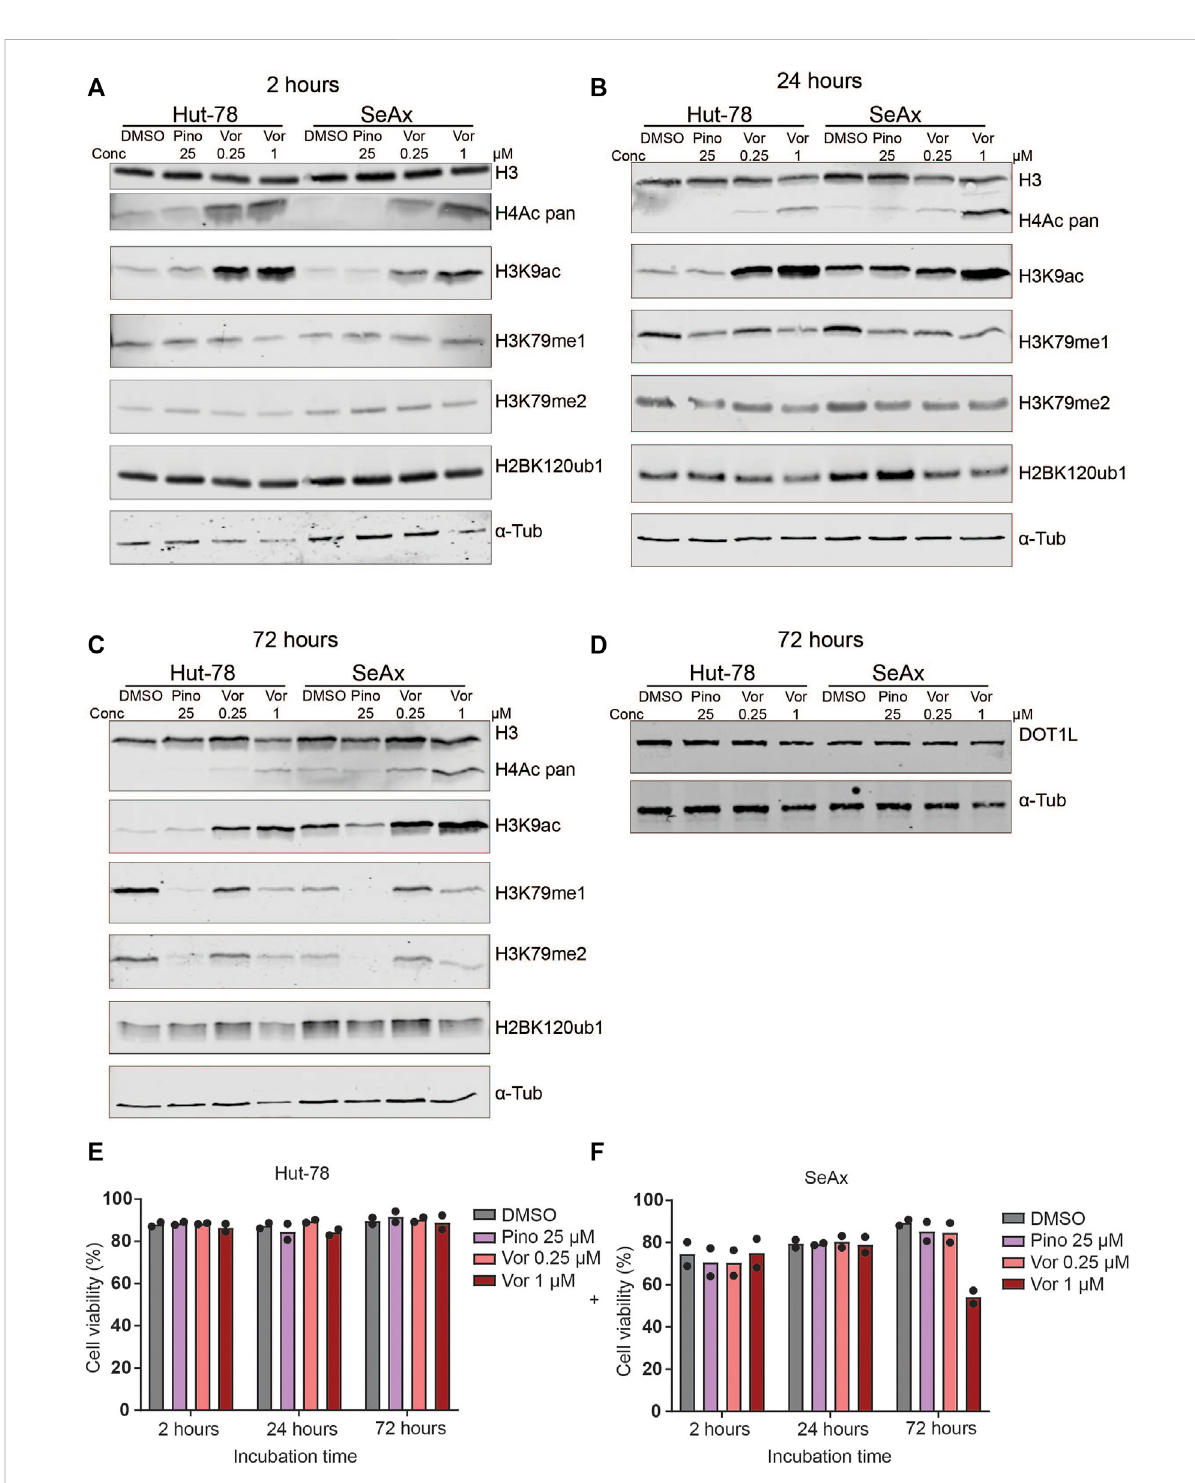
FIGURE 1 Histone modi fi cationlevelsafter treatment ofCTCL lineswithHDACinhibitorsandDOT1Linhibitors. (A – C) Westernblots showingH3K79me1/ 2, pan H4ac, H3K9ac and H2BK120ub1 levels in the indicated CTCL cell lines after treatment with 25 µM Pinometostat (Pino), and 0.25 µM or 1 µM Vorinostat (Vor) for 2 h (A) , 24 h (B) or 72 h (C) . (D) Western blot on unsonicated samples showing DOT1L protein levels in the indicated CTCL cell lines after treatment with 25 µM Pinometostat (Pino), 0.25 µM or 1 µM Vorinostat for 72 h. (E – F) Cell viability of the indicated CTCL cell lines after treatment with 25 µM Pinometostat (Pino), and 0.25 µM or 1 µM Vorinostat for 72 h determined by Annexin V-DAPI staining. Bars indicate average value of two independent biological replicates; individual data points are